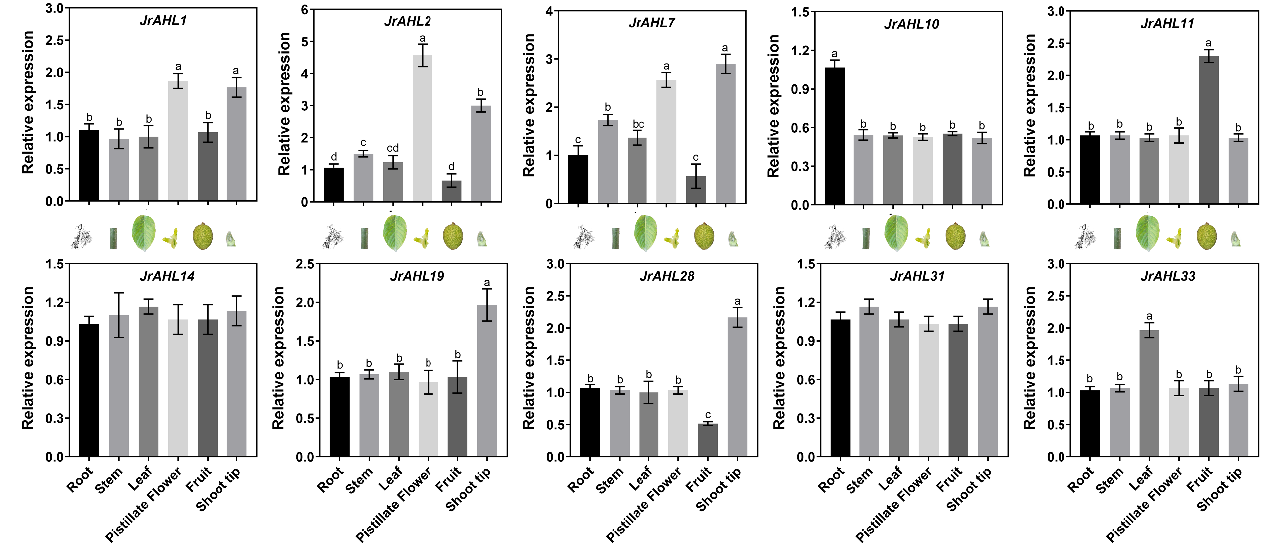
Figure 9. JrAHL gene expression profiles in different tissues. Each value represents the mean ± standard error of three replicates. Different letters (a, b, c, d) indicate significant differences, as de- termined by Student’s t - test at the 0.05 level.